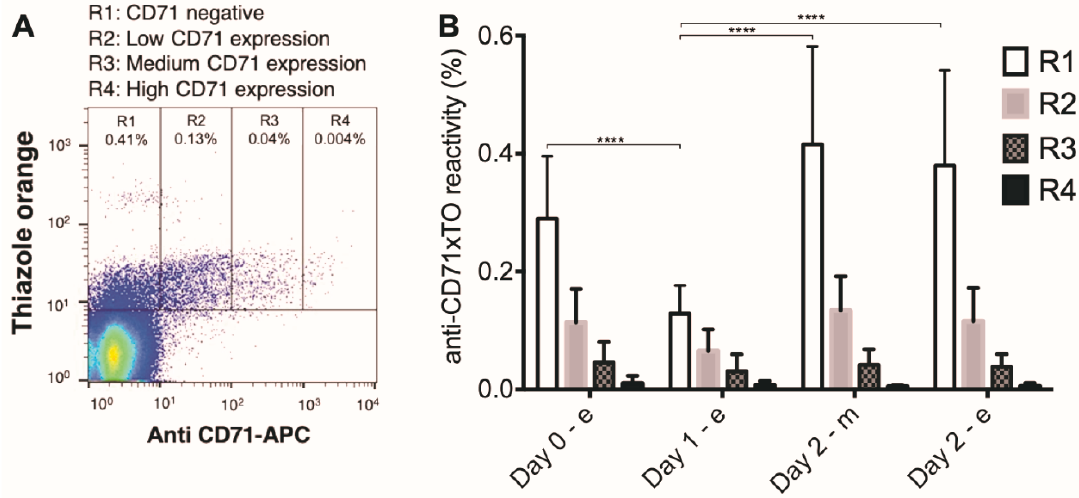
Figure 3. Changes in the fraction of reticulocytes during the Nijmegen Four Days Marches. ( A ) The numbers of reticulocytes were determined using fluorescent anti-CD71 antibody in combination with thiazole orange: R1, CD71 negative ( p < 0.001), R2, low CD71 expression ( p = 0.0362), R3, medium CD71 expression ( p > 0.05), R4 high CD71 expression ( p > 0.05); ( B ) percentage of each reticulocyte maturation fraction group per day. ***, p < 0.001; ****, p < 0.0001 (N = 10). RBC aging is accompanied by the generation of microvesicles [24]. In the blood of the Four Days Marches participants, we found no significant changes in RBC-derived microvesicle concentrations.